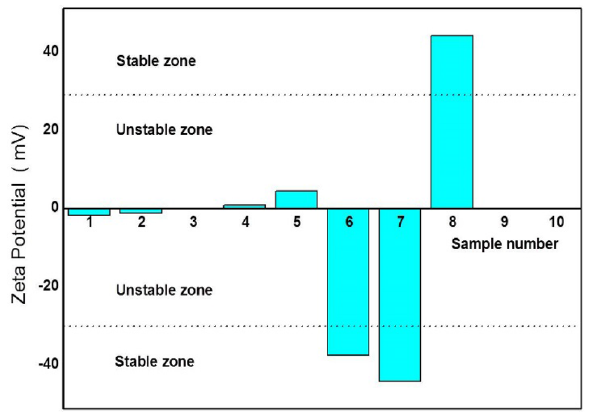
Figure 4. Results of the zeta potential